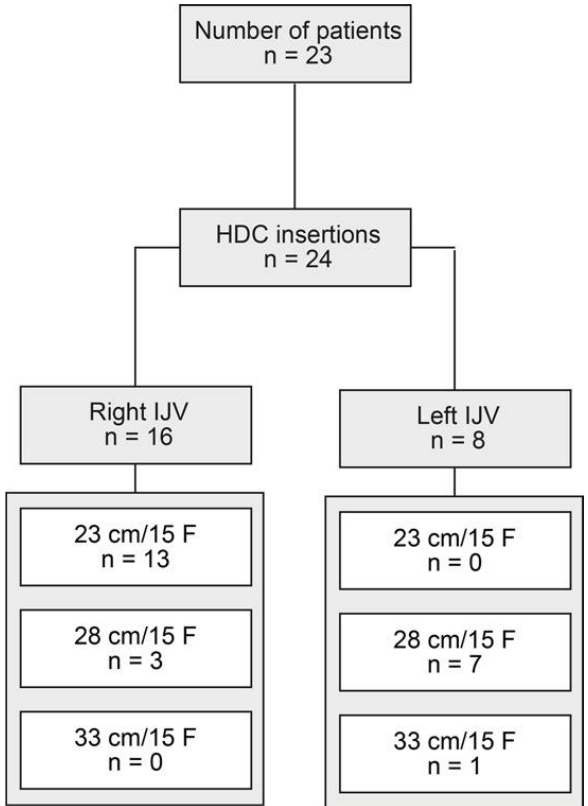
Figure 1. Total patient cohort. STROBE flow chart of patient disposition, with indication of retrograde-tunneled HDC insertion. Abbreviations: cm, centimeter; F, french; HDC, hemodialysis catheter; IJV, internal jugular vein; STROBE, Strengthening the Reporting of Observational Studies in Epidemiology. Table 2. Laboratory parameters at the time of 24 HDC insertions.